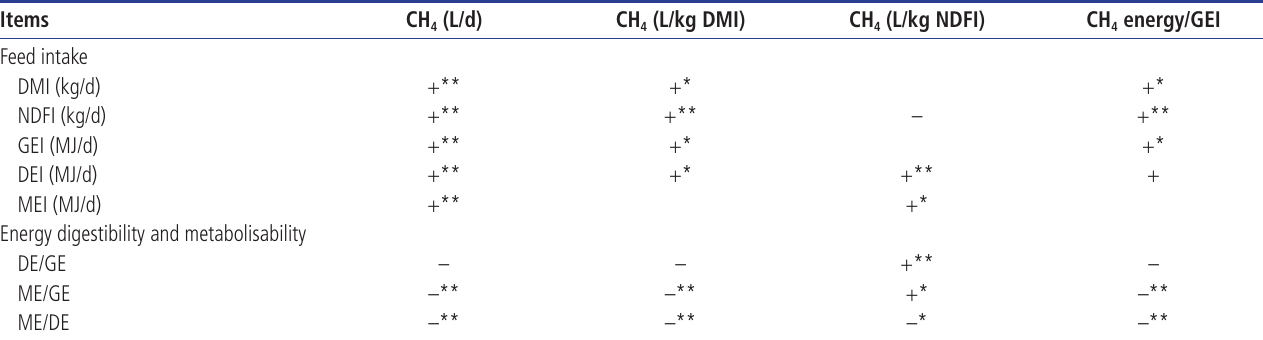
Table 2. Significant levels for the linear relationships between methane output from animal and dietary